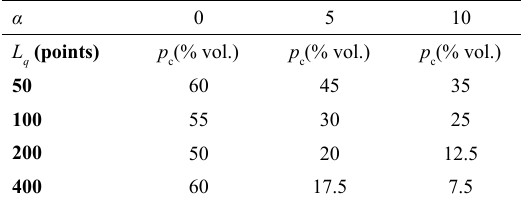
Table 4. Percolation threshold values for CB systems: variation and value of of L q